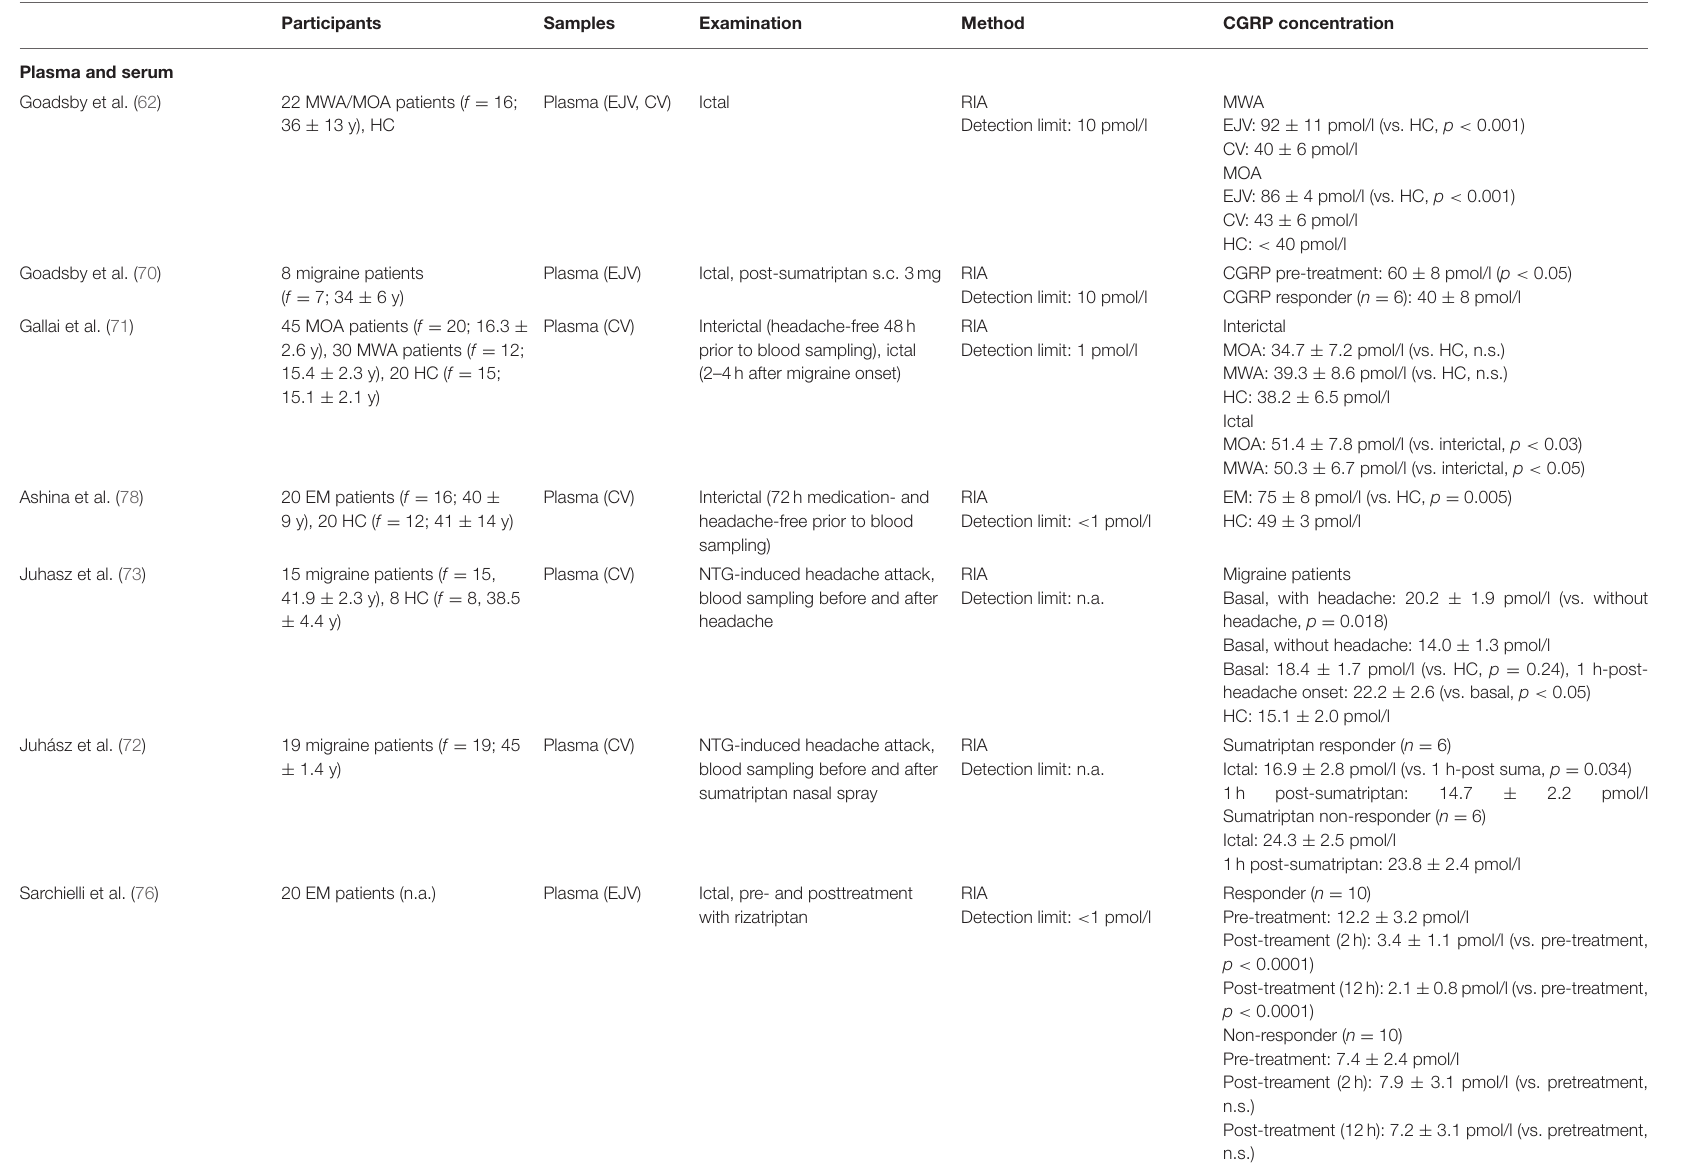
TABLE 1 | Overview of studies investigating CGRP in blood, saliva, and tear